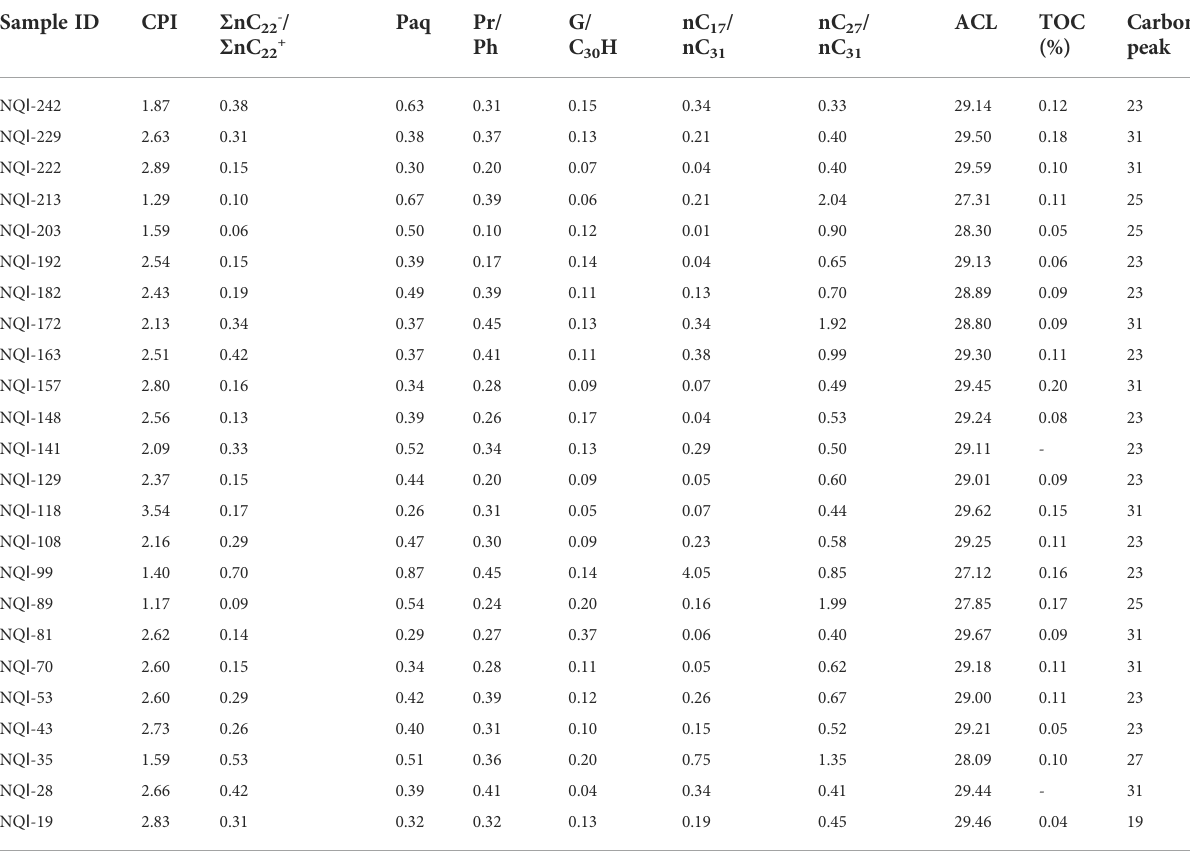
TABLE 1 Organic geochemical index parameters of samples from the Nangqian